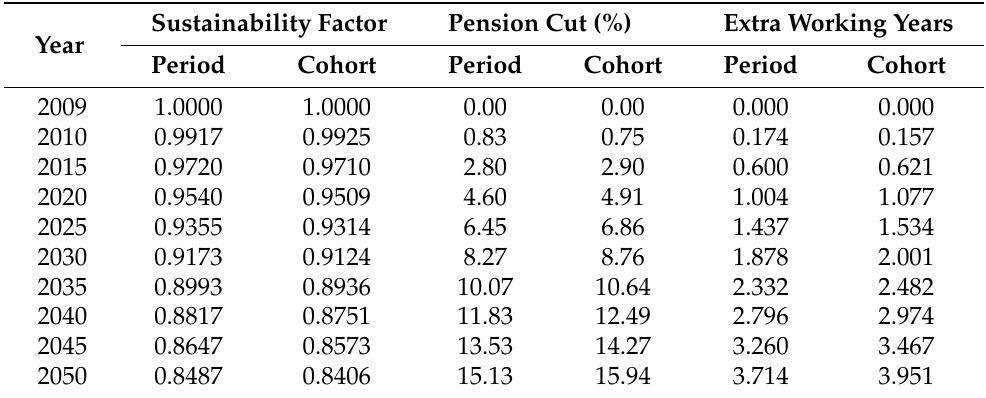
Figure 3. Finland: forecasts of the life expectancy and sustainability factor. Notes: the solid lines in the left panel represent the period (PER) or cohort (COH) life expectancy estimates at the age of 62, with the dashed lines representing the corresponding 95% MATA prediction intervals. In the right panel, the dots correspond to the observed values of the life expectancy coefficient. Computations are based on 1-year life expectancy and life annuity estimates rather than the 5-year estimates used in Finland. Table 2. Finland: Sustainability factor, pension cuts, and extra working years